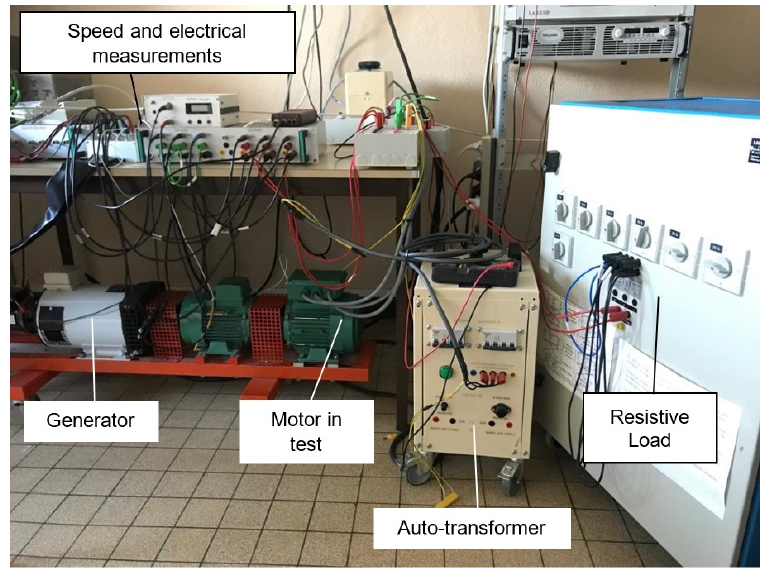
Figure 2. Experimental set-up.